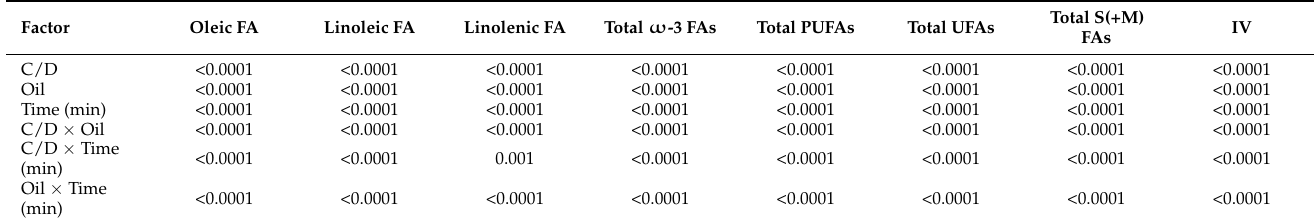
Table 4. Statistical significance of main factors (continuous (C) versus discontinuous (D) thermal- stressing methods (C/D), oil type and heating time (min), along with their three first-order interaction effects, obtained from an ANOVA analysis of the FA composition and IV dataset (Model 1).